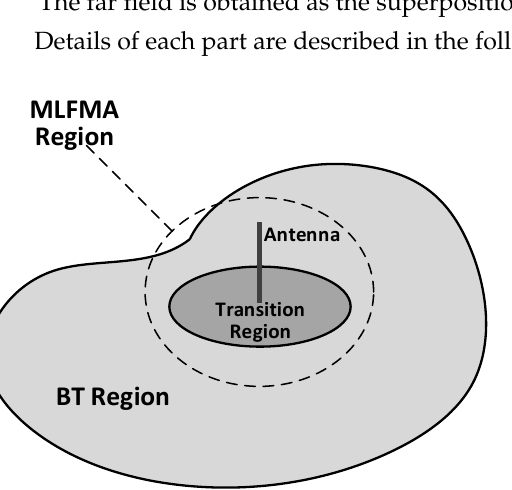
Figure 1. The division of the MLFMA region and BT region for the whole structure.